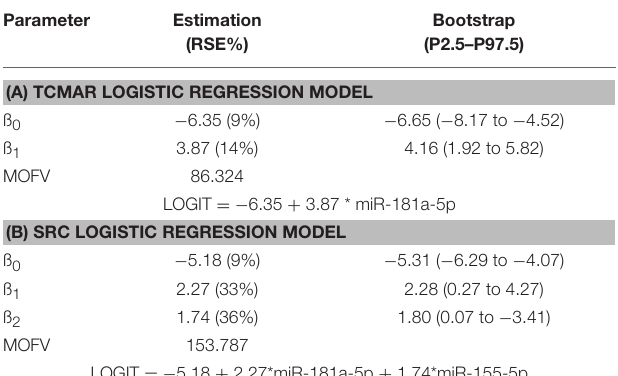
TABLE 3 | Logistic regression model parameters.